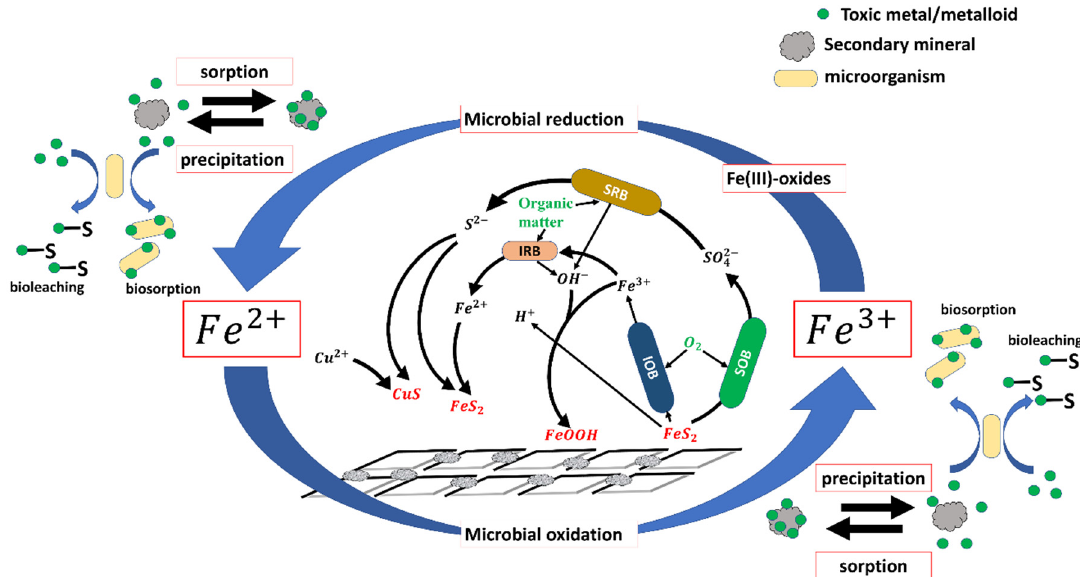
Figure 6. Schematic of the role of microorganisms in the bioremediation of pyritic mine rock. Adapted from [212]. SOB: sulfur-oxidizing microorganisms; IOB: iron-oxidizing microorganisms; IRB: iron-reducing microorganisms; SRB: sulfur-reducing microorganisms.